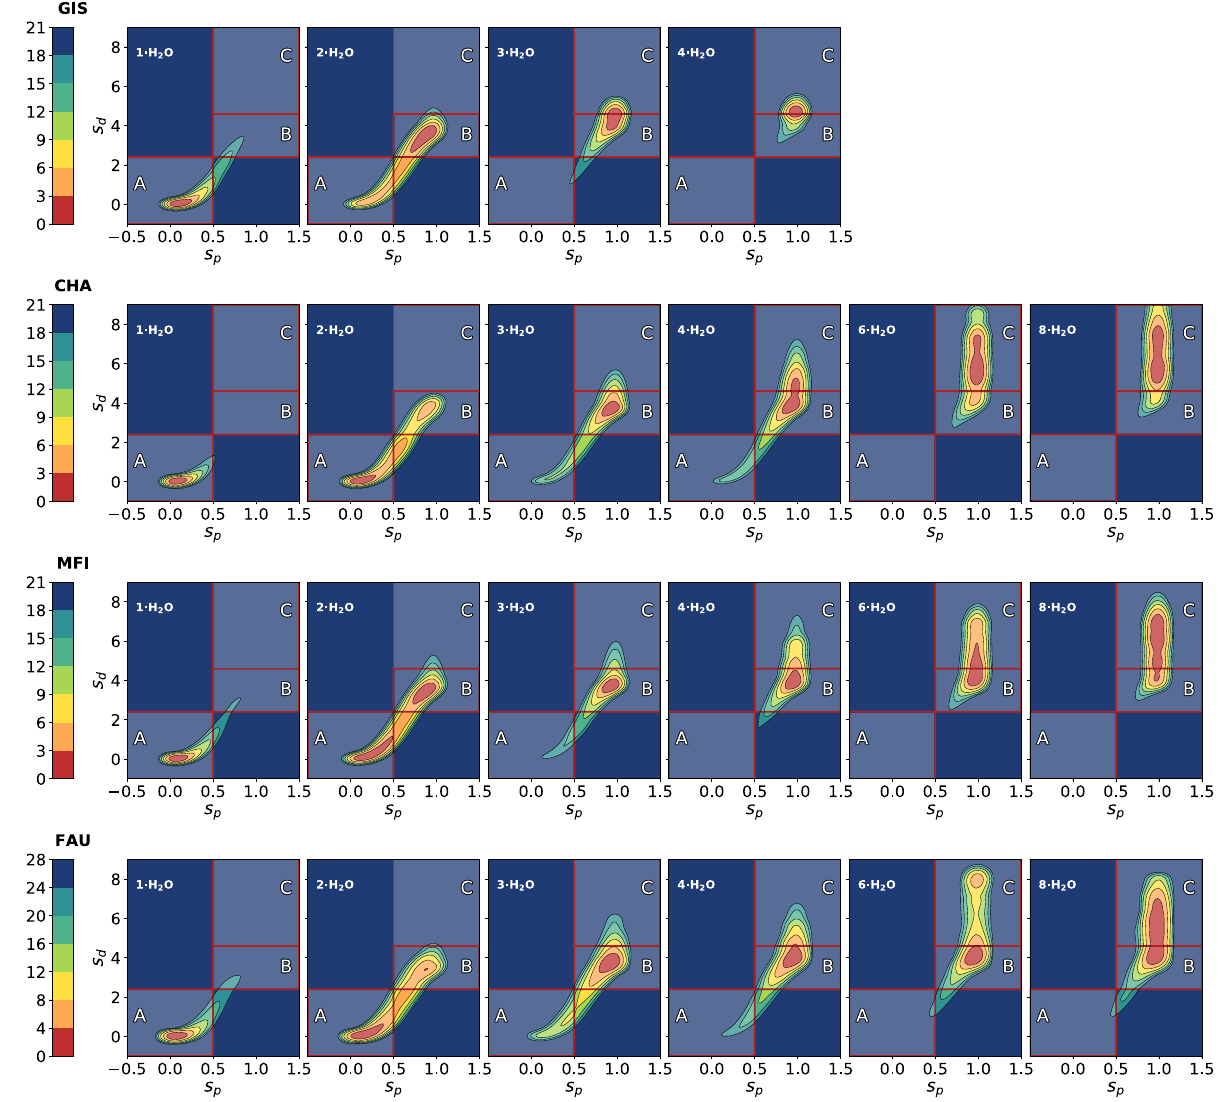
Fig. 4 Deprotonation free energy surfaces. These plots report FESs projected along s p and s d at different hydration levels for the four acidic zeolites. In the case of Gismondine, FES with the cluster made by 6 and 8 water molecules are not present since these systems could not be studied. Differences in free energies are expressed in kJ mol − 1